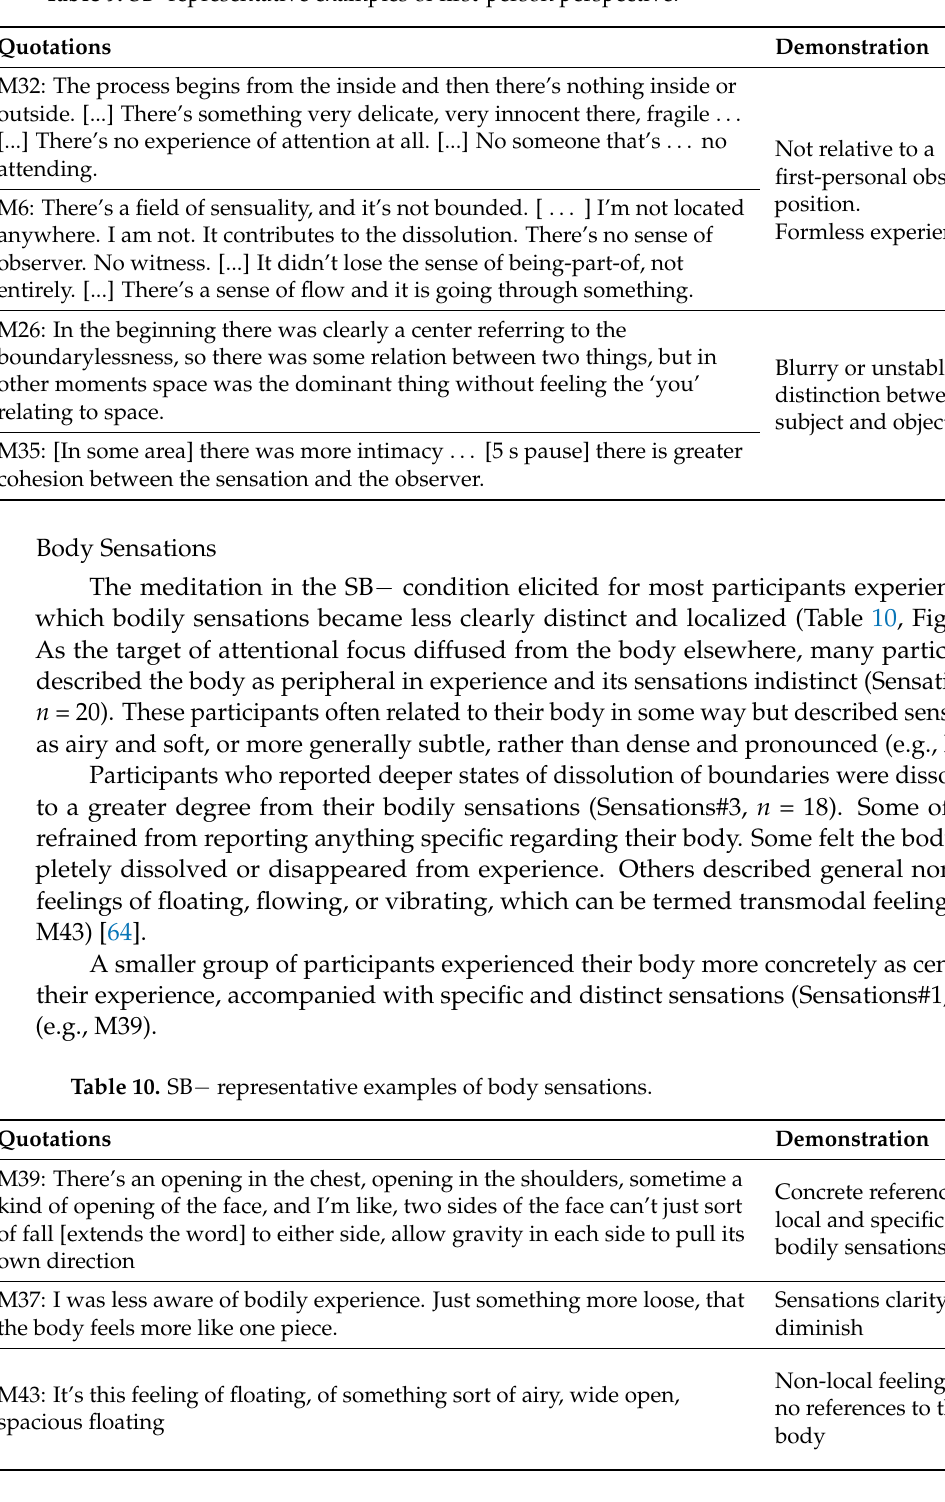
Table 9. SB- representative examples of first-person perspective.